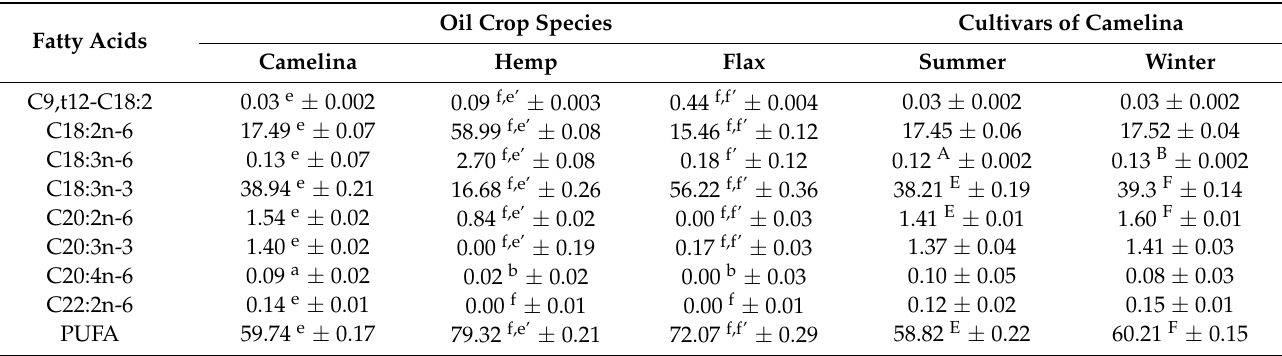
Table 4. Effects of oil corn species and camelina cultivars of different sowing seasonality on polyunsaturated fatty acid (% of total FA) composition in seed